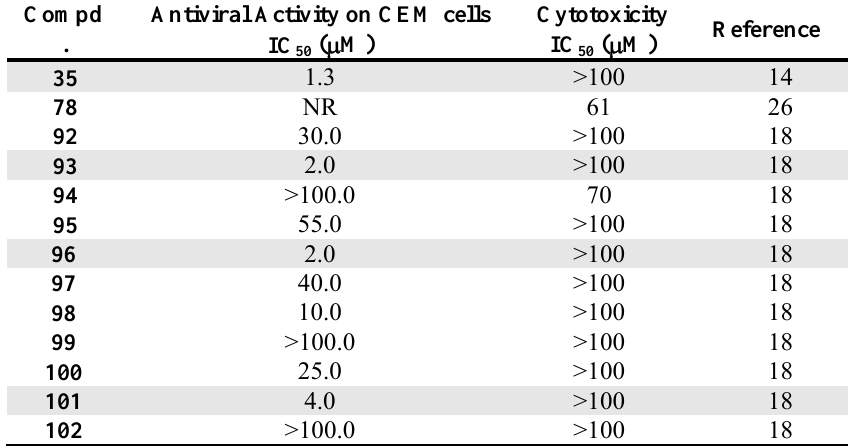
Table 12. Antiviral activity and cytotoxicity of spacer modified inhibitors.